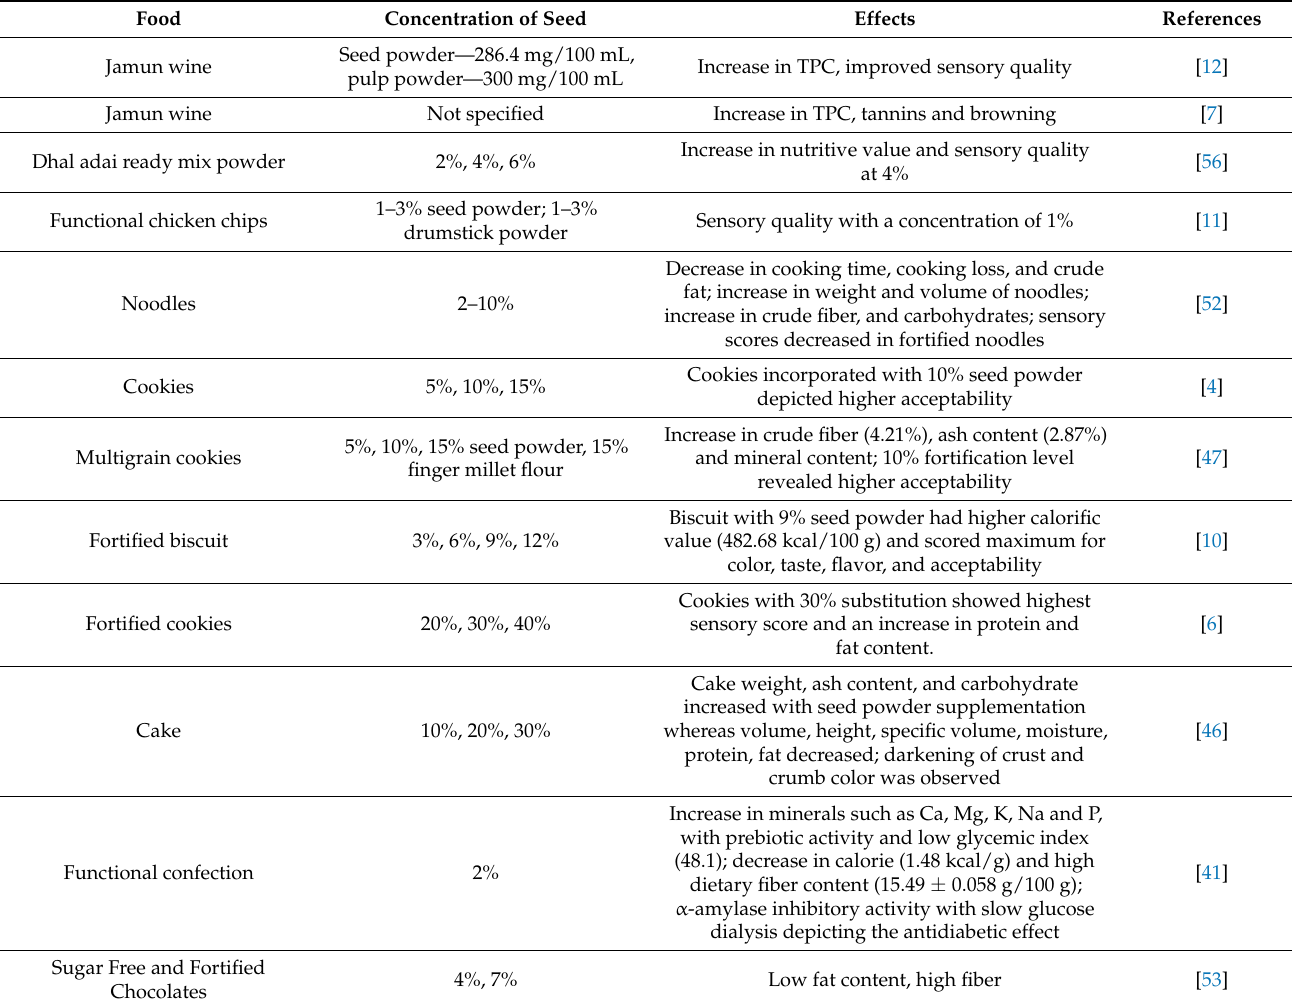
Table 3. Applications of jamun seeds in